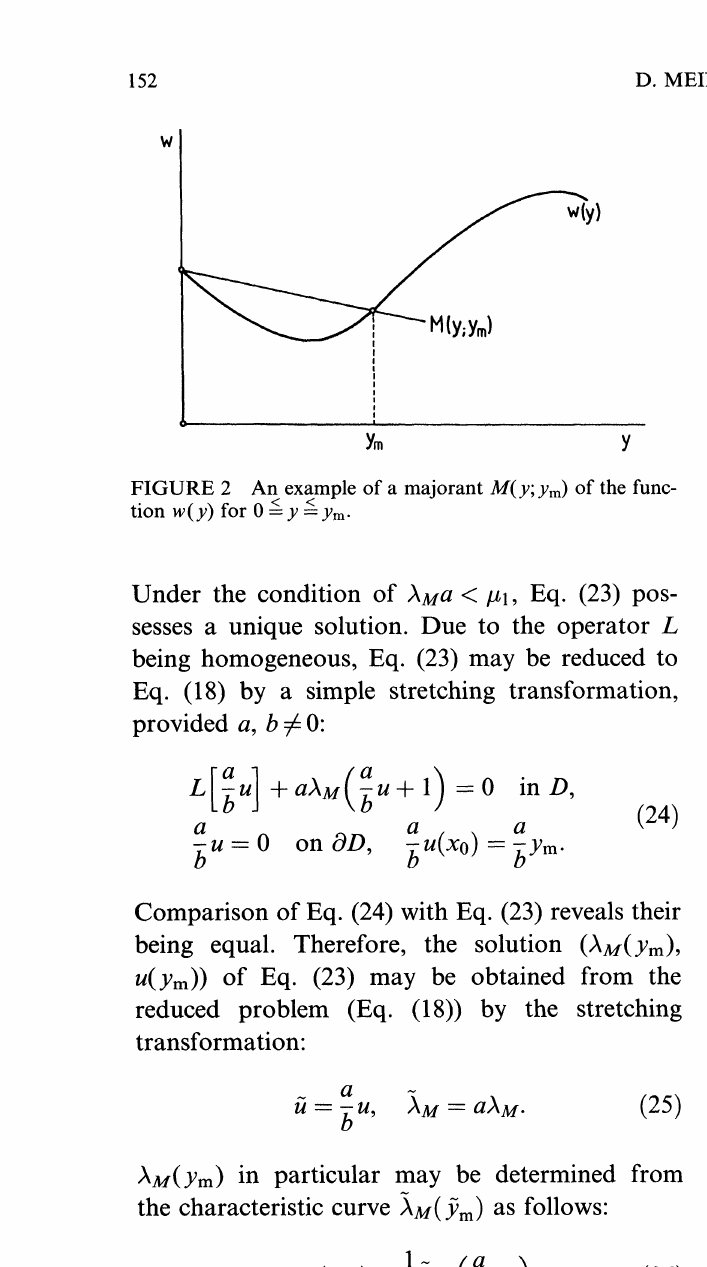
FIGURE 3 A strictly increasing function w(y) which is convex-concave for 0 < < =Y